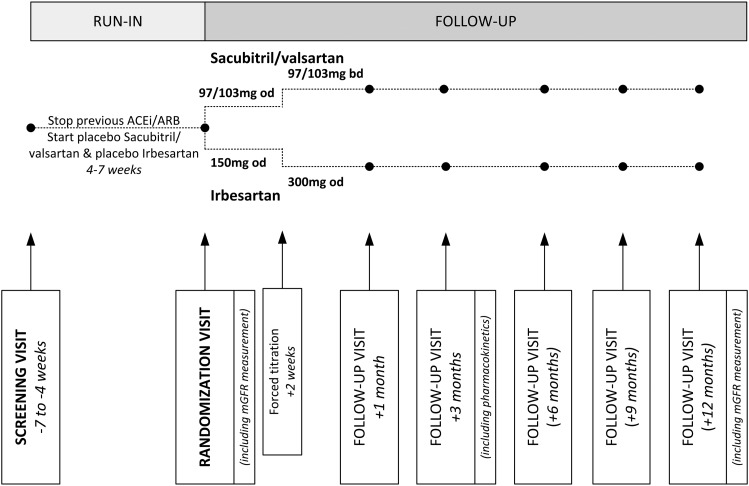
UK HARP-III trial design.